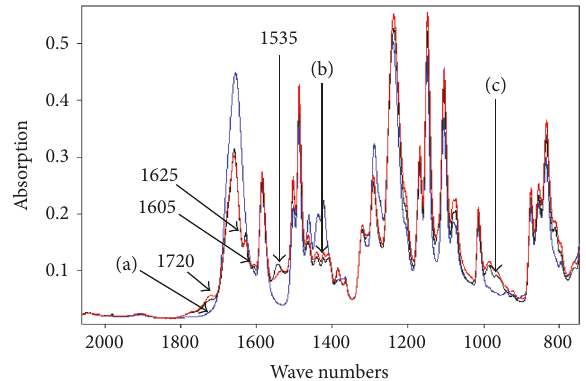
Figure 4: The ATR-FTIR spectra of the (a) unmodified flat sheet PES membrane and modified membranes using UV-induced graft- ing with (25 wt% AA); (b) 20; and (c) 15 minute UV irradiation time, respectively.